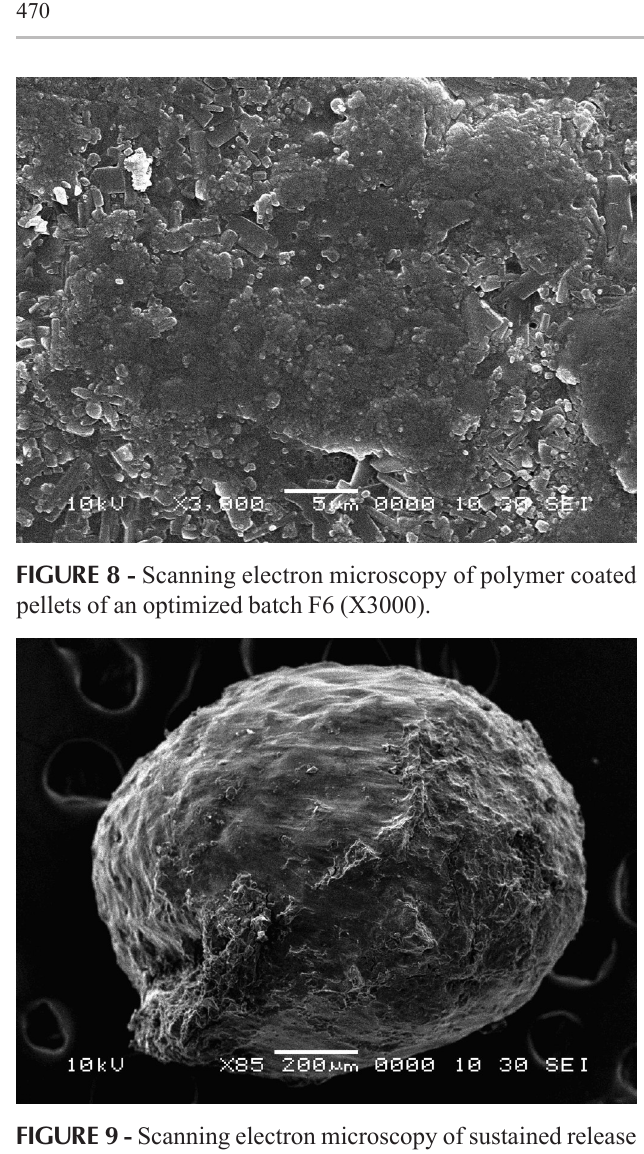
FIGURE 9 - Scanning electron microscopy of sustained release pellets after compression (X85).